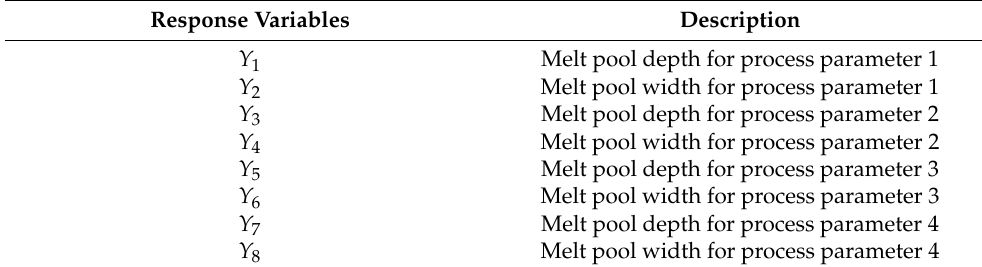
Table A1. Description of response variables.